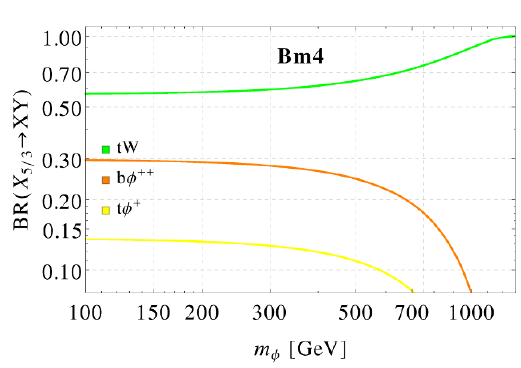
Figure 5 . Branching ratios of X m for the benchmark model Bm4 introduced in section (cid:30) ++